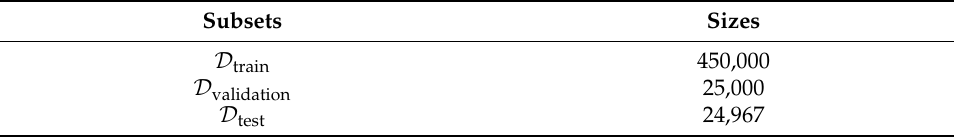
Table 4. The partition of the set D